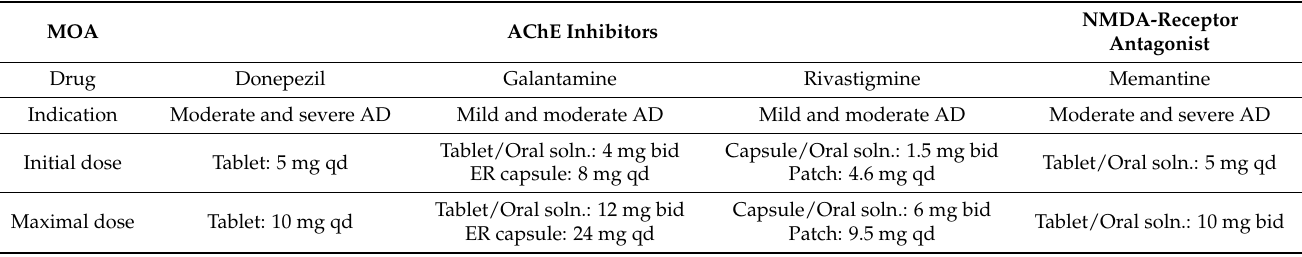
Table 1. Pharmacological treatments available for Alzheimer’s